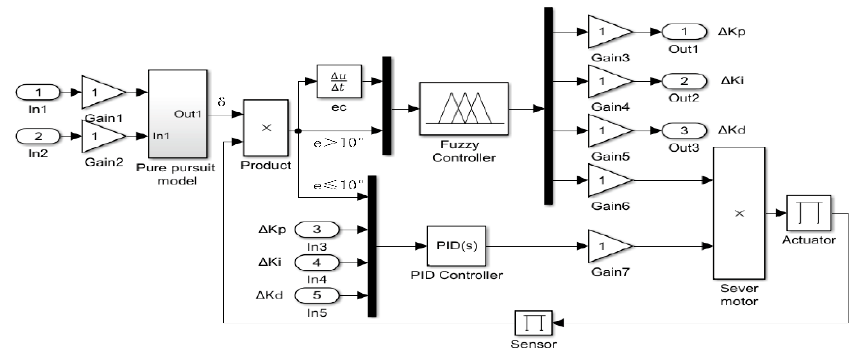
Figure 6. Compound fuzzy PID control simulation diagram.